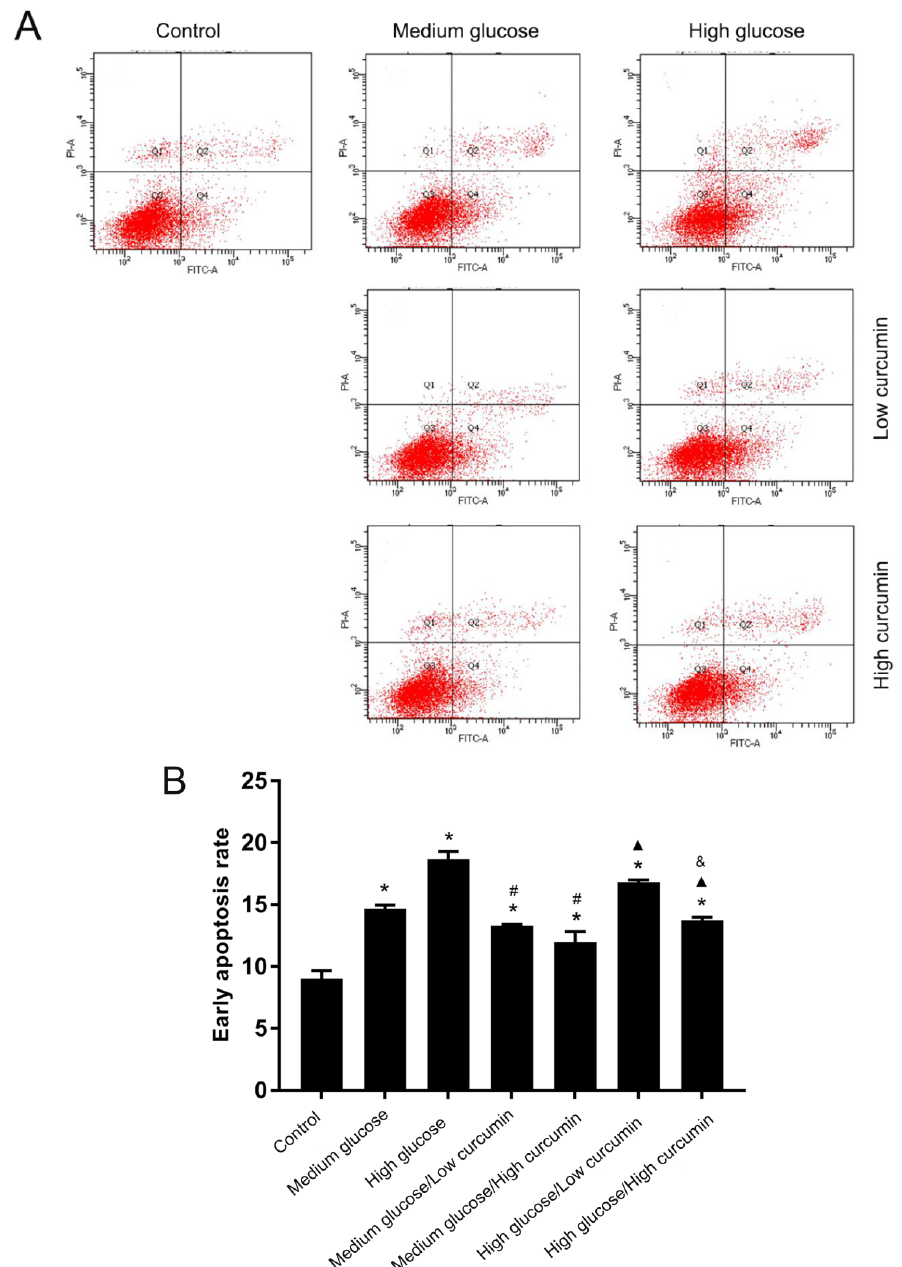
Figure 2. Effects of curcumin on apoptosis of MC3T3 cells in high-glucose conditions. Cell apoptosis was assessed by staining the cells with Annexin V-FITC/PI double staining kit and subsequent analysis by flow cytometry. ( A ) Detection of the early apoptosis rate of MC3T3 cells using flow cytometry. ( B ) The bar chart shows the mean of early apoptosis rate ( n = 3). * p < 0.05 vs the control group; # p < 0.05 vs the medium glucose group; ▲ p < 0.05 vs the high glucose group; and & p < 0.05 vs the high glucose/low curcumin group.